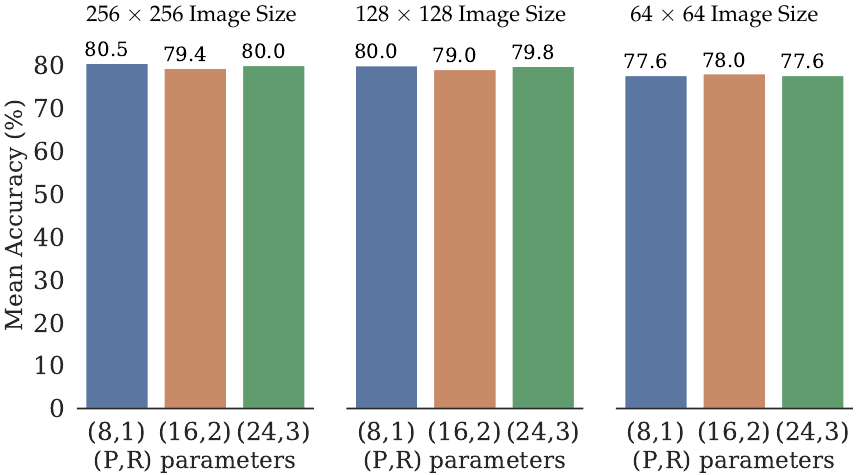
Figure 10. The mean of the Accuracy for each of the ( P , R ) defined